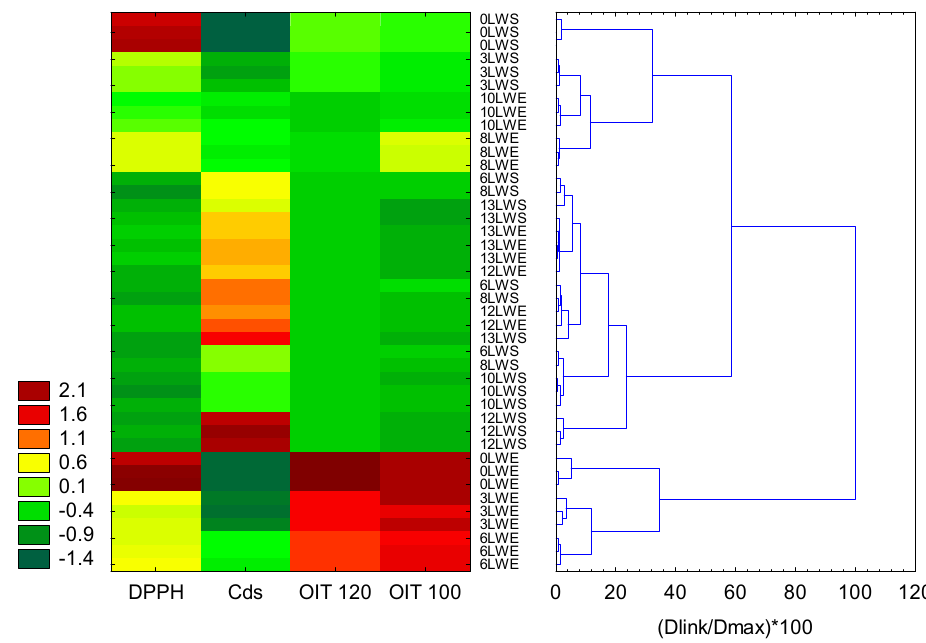
Figure 5. Heat map with the dendrogram of LWS (standard wafers) and LWE (wafers with fruit extract) samples classified using cluster analysis of similarities. Note: DPPH—antioxidant activity; CD—diene concentration; OIT—oxidation induction time 100 °C or 120 °C. Data was standardized.